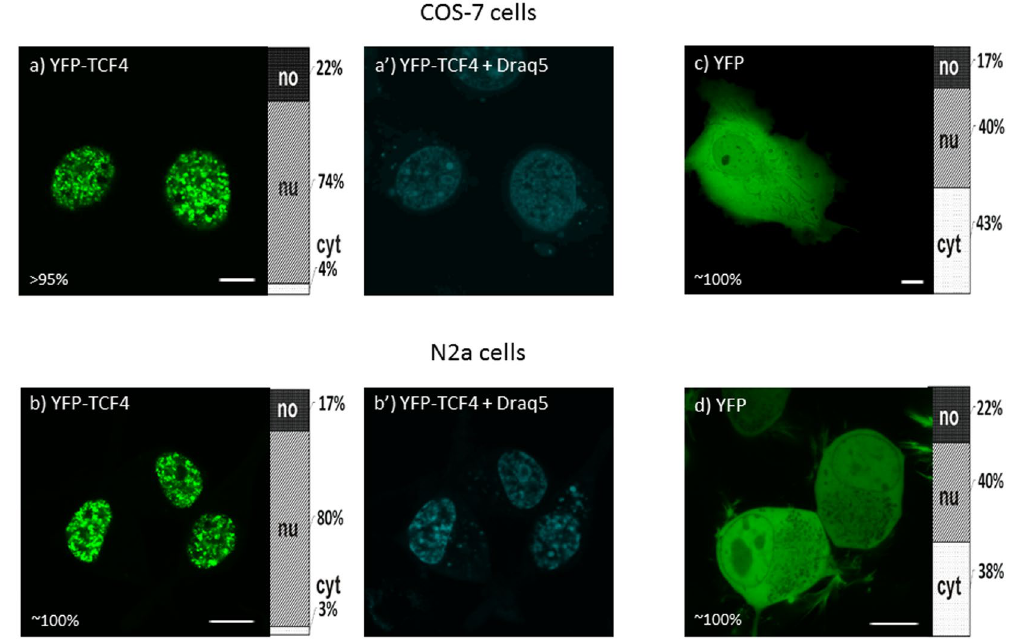
Figure 1. Subcellular distribution of full-length TCF4. Subcellular localization of YFP-tagged TCF4 was analysed by confocal microscopy 20-24 h after transfecting COS-7 and N2a cells. Draq5 was added to the cells for DNA visualization. Ratios between mean fluorescence intensity in cytoplasmic, nuclear and nucleolar compartments are presented as an accumulated bar graph (no- nucleolus; nu- nucleus, cyt- cytoplasm). ( a ) Representative images (single confocal plane) of the subcellular distribution of YFP-TCF4 ( a -b’) and YFP ( c - d ) in COS-7 and N2a cells. Bar, 10 µ m. no- nucleolus; nu- nucleus, cyt-